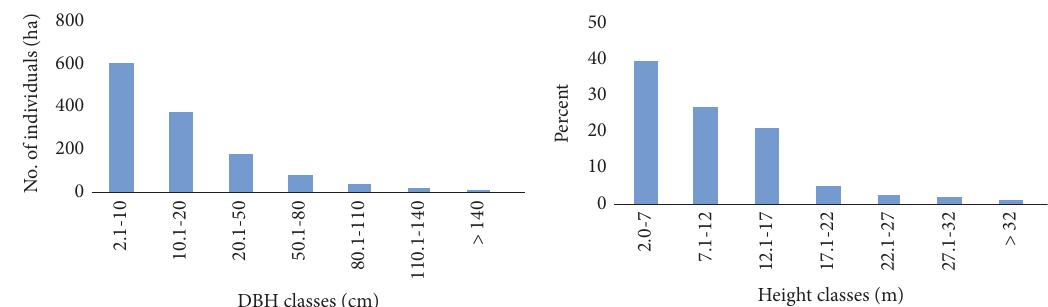
Figure 2: DBH and height class distribution of woody species in Abbo Sacred Forest. Table 3: Importance value index (IVI) of trees and shrubs in Abbo Sacred